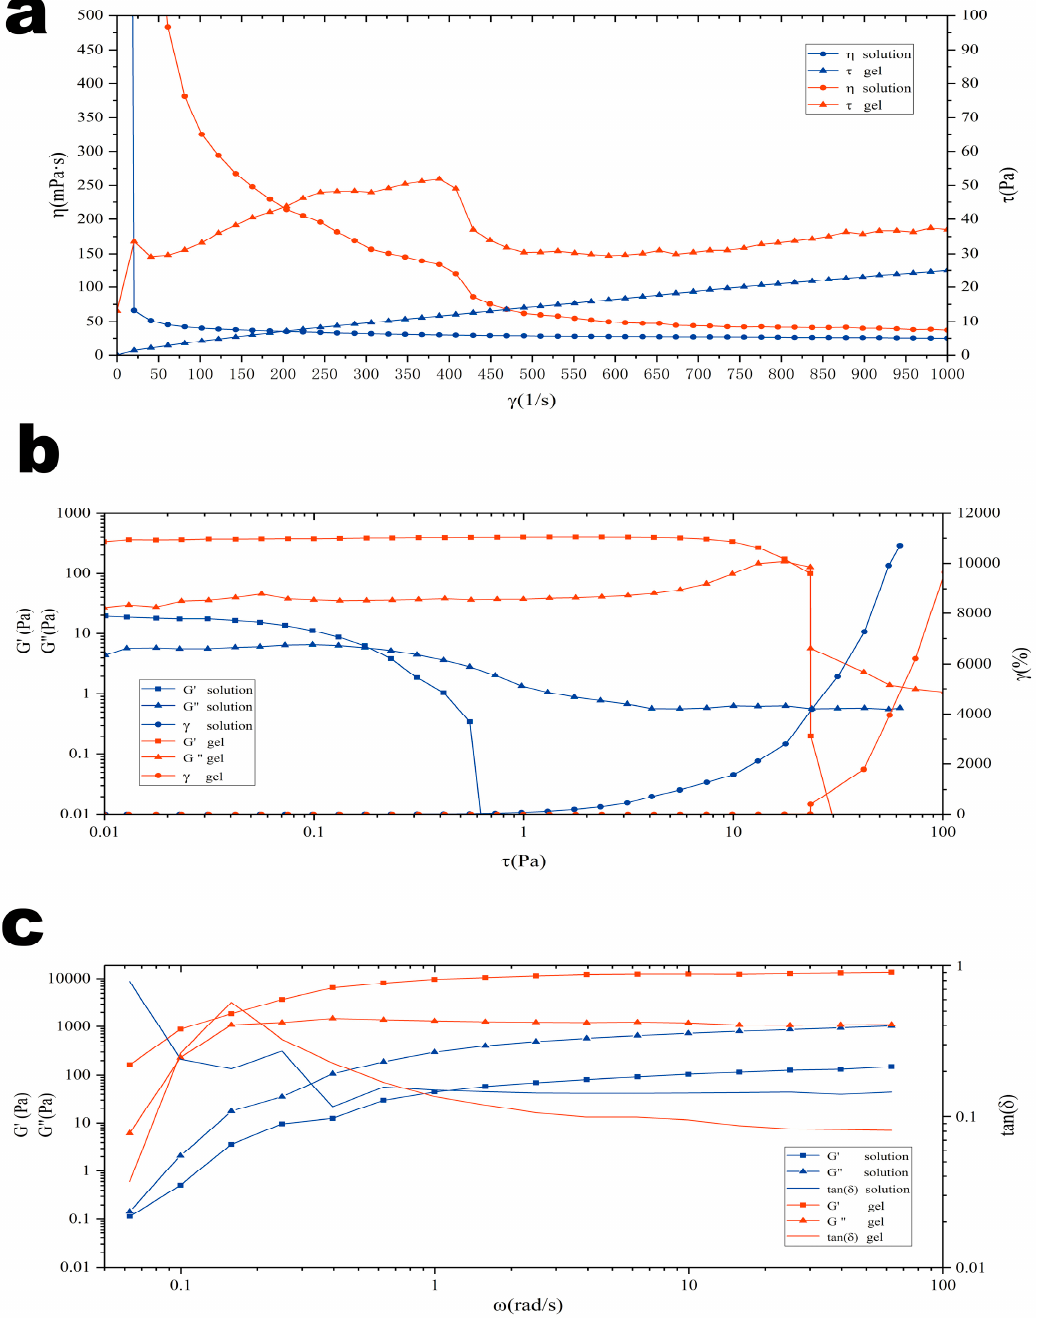
Figure 6. Rheological evaluation of the DGG in situ gel with PAE/mPEG-PAMAM G5.NHAc at 34 ◦ C. ( a ) Rheology characterisitics of the DGG solution and the DGG in situ gel; ( b ) stress strain of the DGG solution and the DGG in situ gel; ( c ) frequency sweep of DGG solution and the DGG in situ gel.